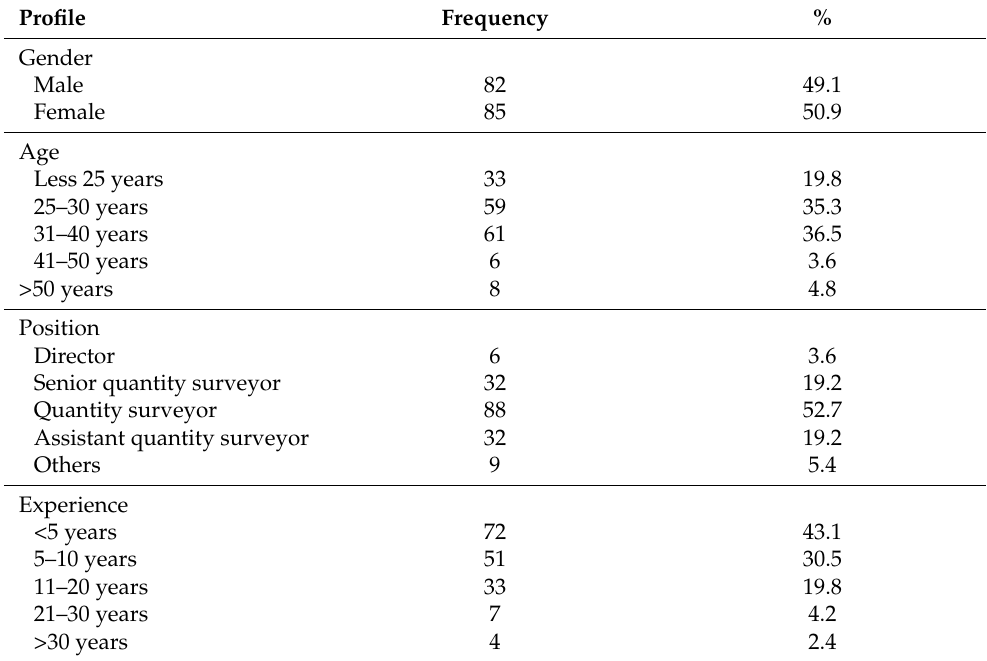
Table 1. Demographic characteristics of